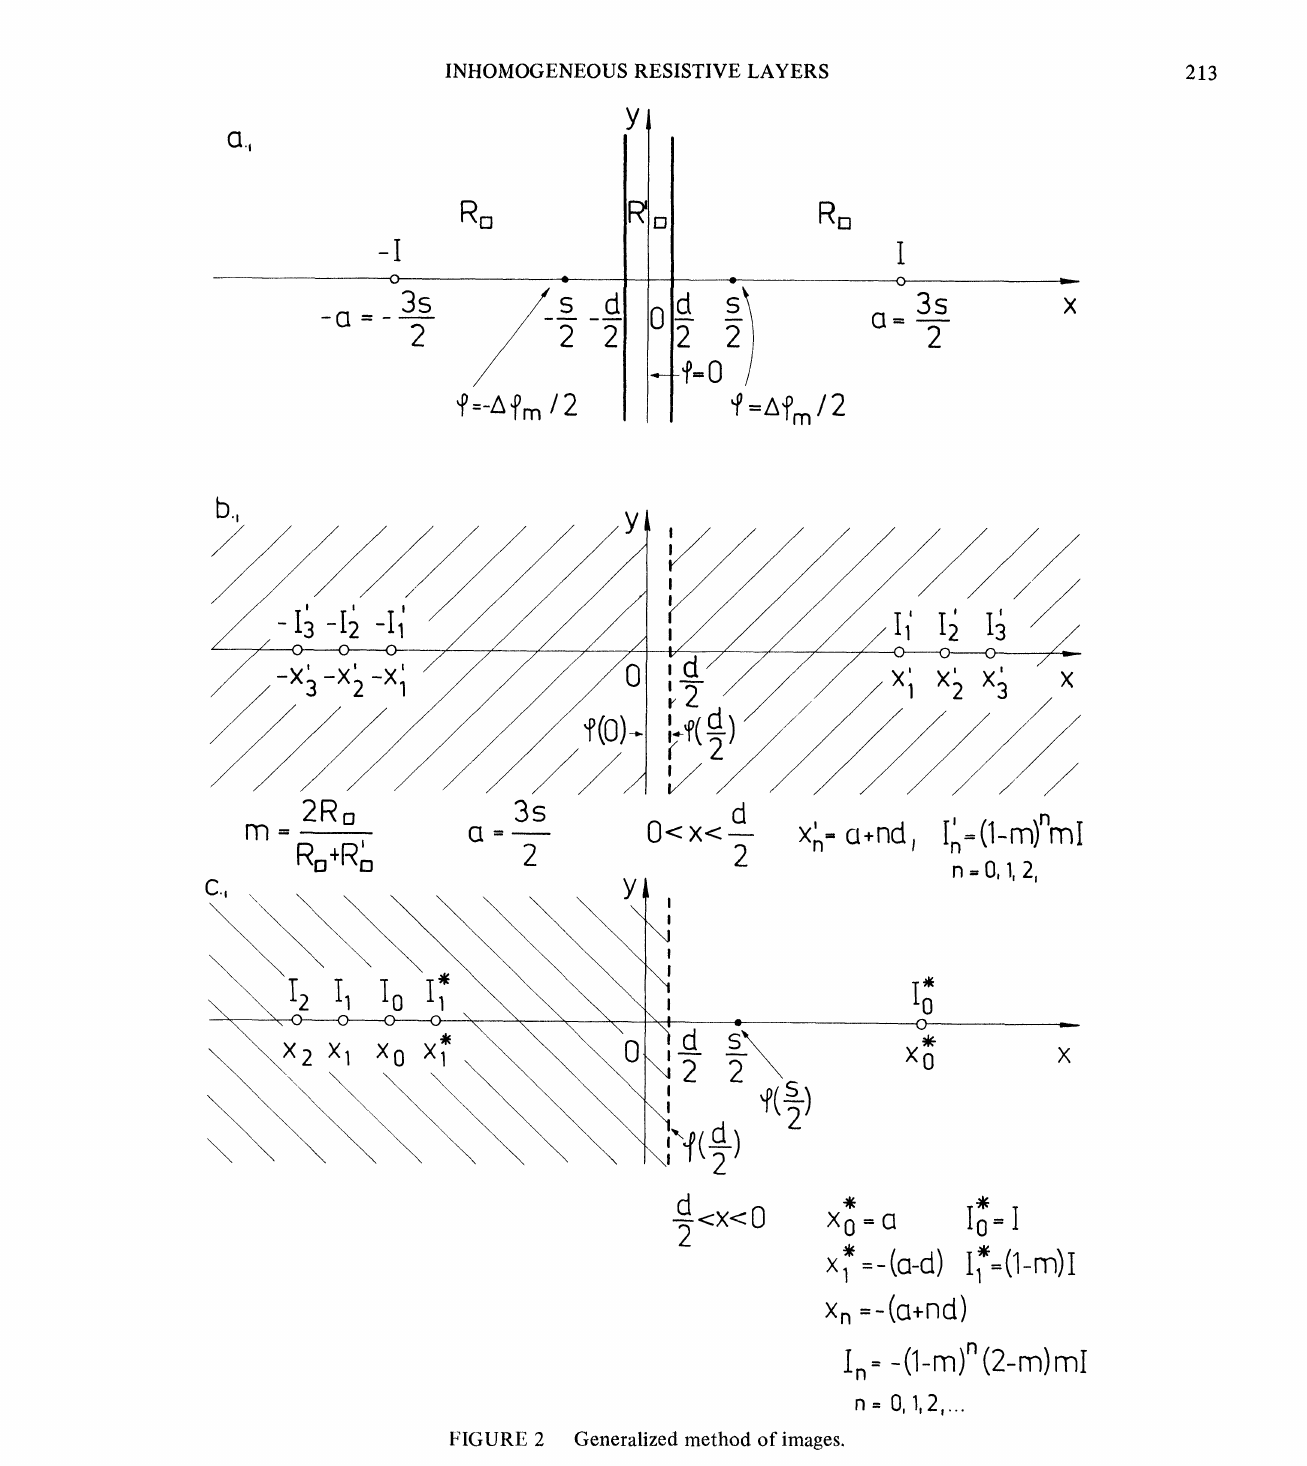
FIGURE 2 Generalized method of